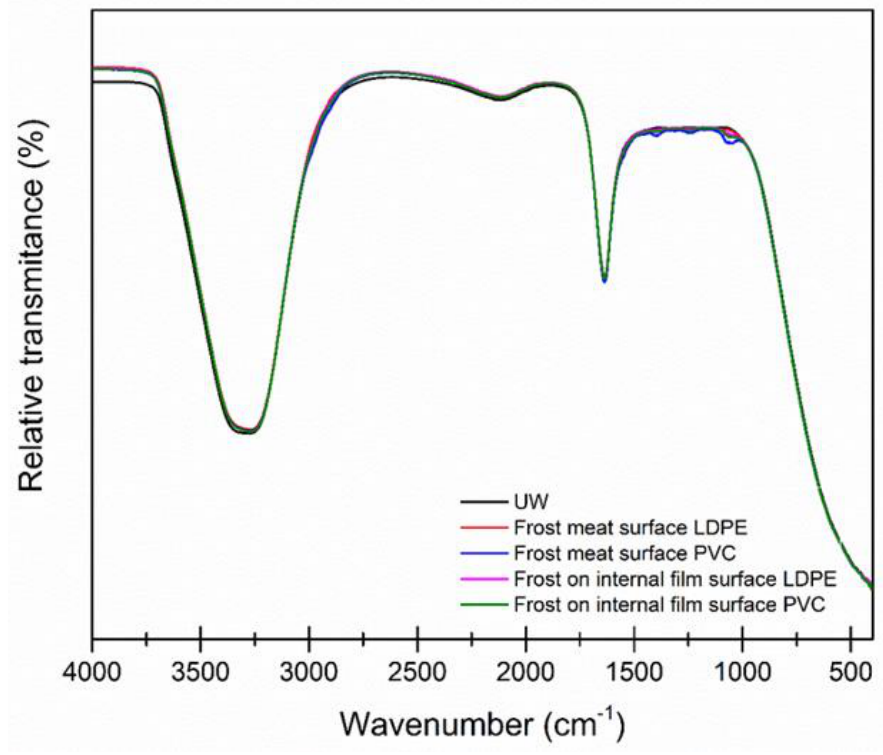
Figure 4. Infrared spectrum of frost water in the containers.